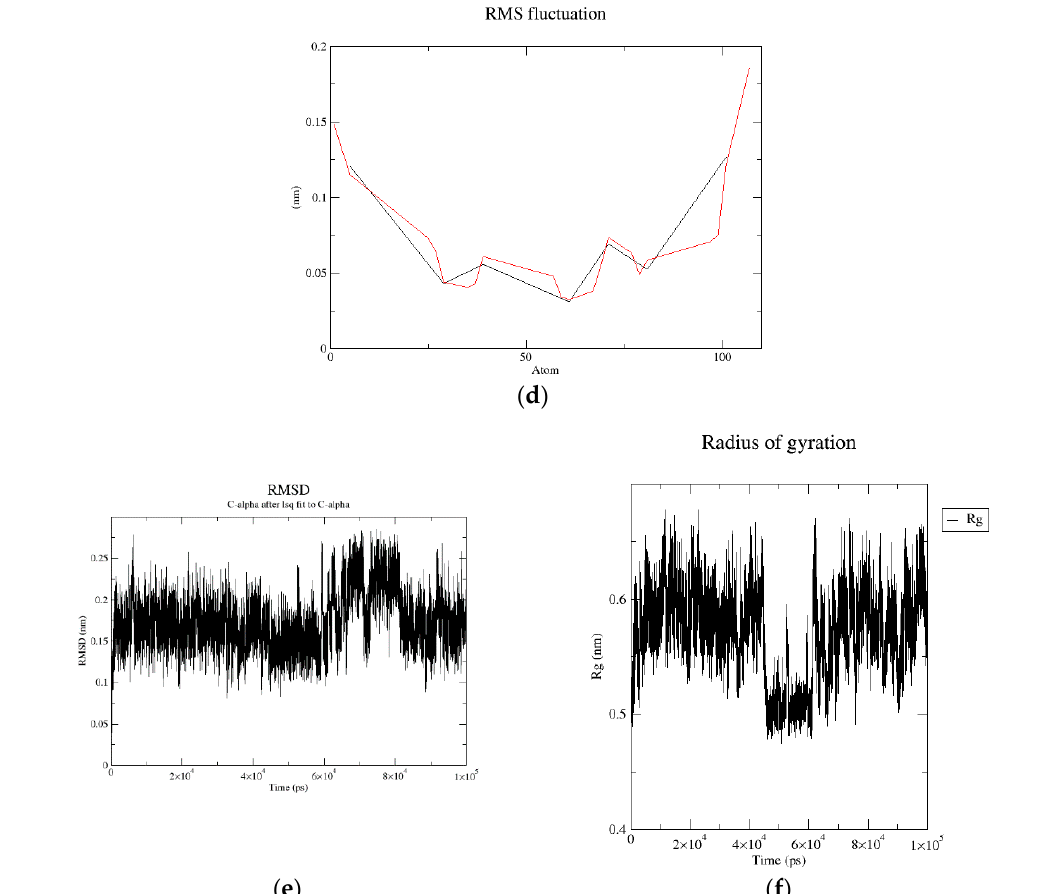
Figure 2. ( a ) Free energy surfaces (in kcal/mol) for the aggregation of AH-798 forming a disulfide bridge in terms of the radius of gyration (Rgyr) and the root mean square deviation (RMSD). The darker region represents the lower energy of the structure, and the conformation with the lowest energy is indicated with an arrow. ( b ) Potential energy (black), kinetic energy (red) and total energy (green) fluctuation of the system during the production molecular dynamics simulation within 100 ns; ( c ) Lennard-Jones Short Range potential (black) and Coulomb short-range force (red) fluctuation of the system during the production molecular dynamics simulation within 100 ns. ( d ) Root mean square fluctuation (RMSF) of the C α in the structure of AH-798 (indicated with black lines) and the carbon backbone of the structure (indicated with red lines). ( e ) The root mean square deviation (RMSD) values of the C α in the structure of AH-798 during the production molecular dynamics simulation within 100 ns. ( f ) Radius of gyration (Rg) of the whole conformation during the molecular dynamics simulation within 100